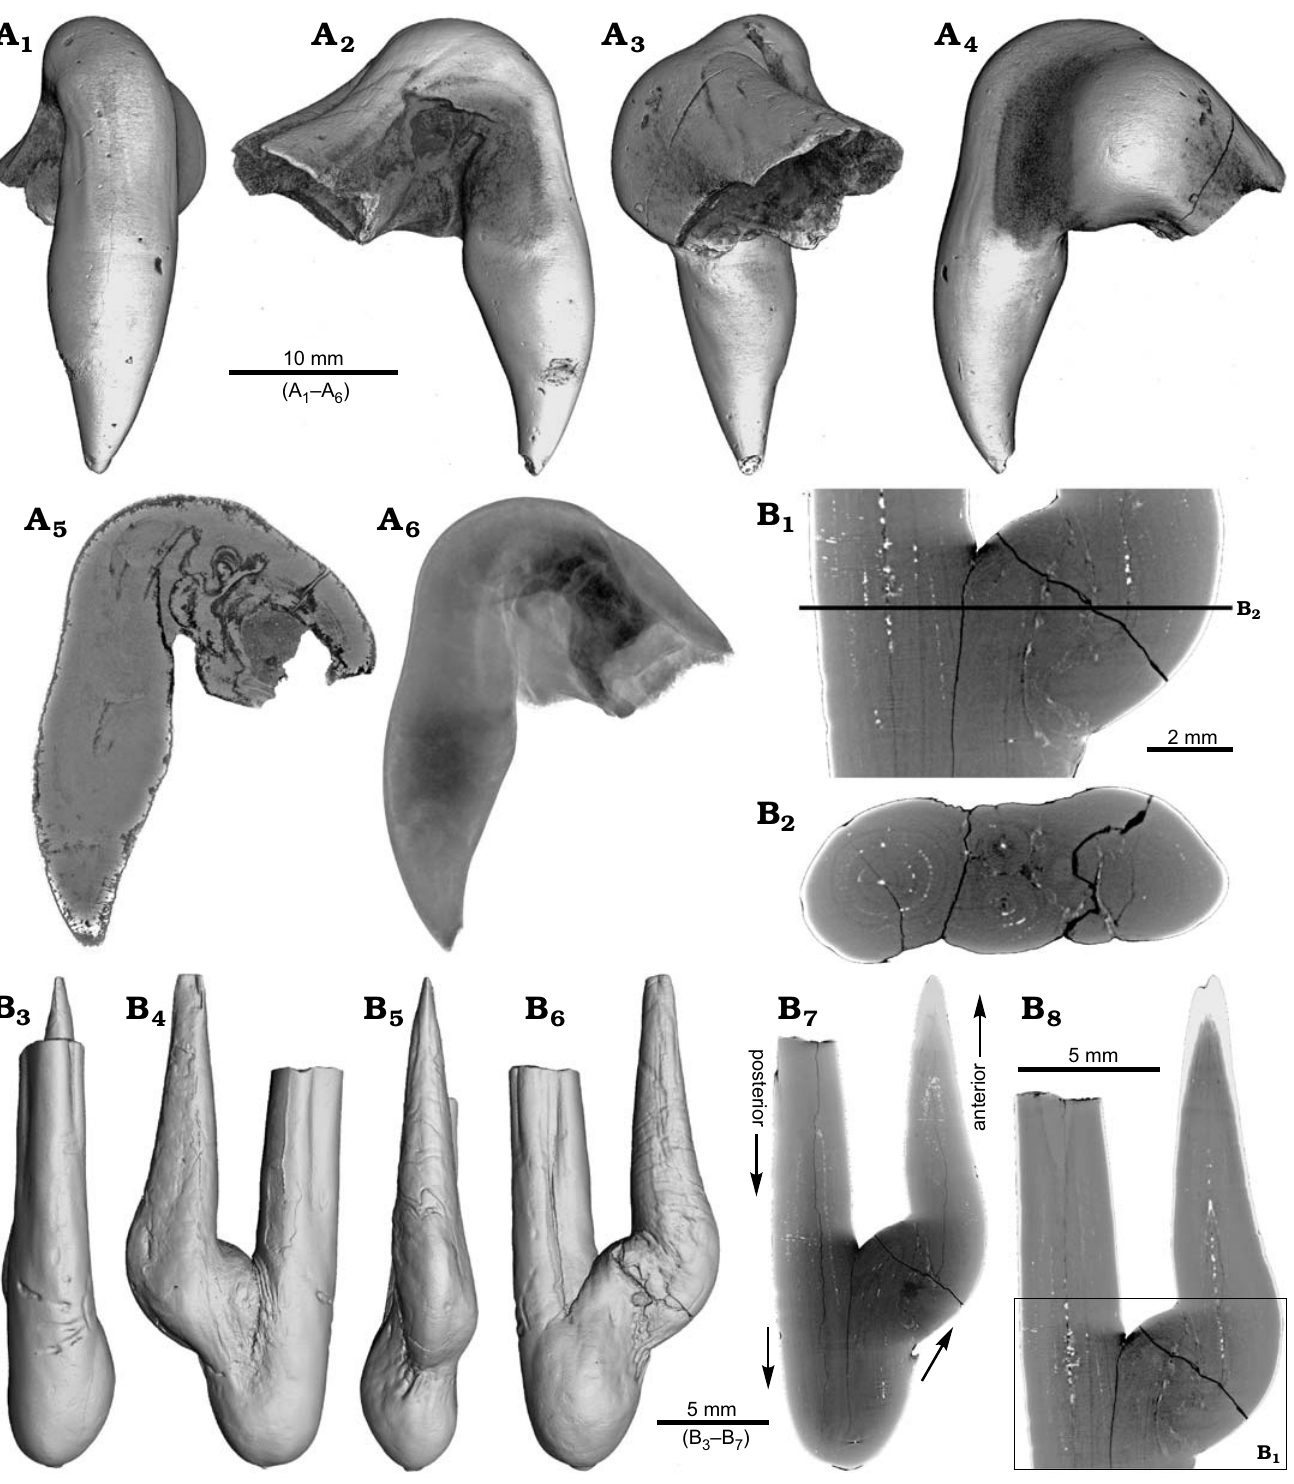
Fig. 7. A . Rostrum of belemnite Gonioteuthis sp., SNSB-BSPG-83370, Campanian, Höver (NW-Germany) with forma aegra hamata (coll. H. Keupp, leg. C. Spaeth). Surface images showing the knee-like strongly bent and irregular morphology of the rostrum (A 1 –A 4 ). Median section showing the irregular internal silification of the rostrum indicating poorly mineralized areas, growth and apical line partially visible (A 5 ). Volume rendering image with the darkest areas represented by the thickest or densest areas (A 6 ). B . Rostrum of belemnite Pseudobelus sp., RUB-Pal 3196, Valanginian, Barret-Meouge (France) with forma aegra hamata (coll. M.-C. Picollier). Surface images showing the strongly bent and irregular morphology of the rostrum with the apex growth in anterior direction (B 3 –B 6 ). Median section overview and close up showing growth increments and the presence of pyrite along the apical line (white) (B 1 , B 7 , B 8 ). Cross section showing four growth center representing a temporal sequence (B 2